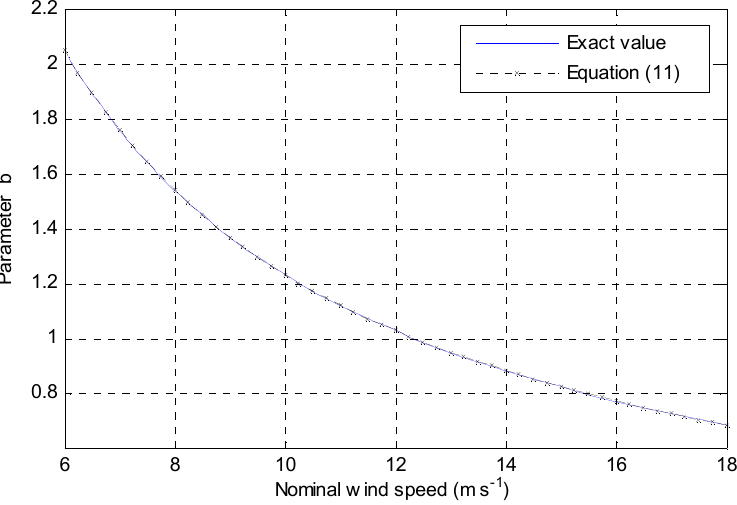
Figure 1. Variation of the value of parameter b vs . nominal wind speed.